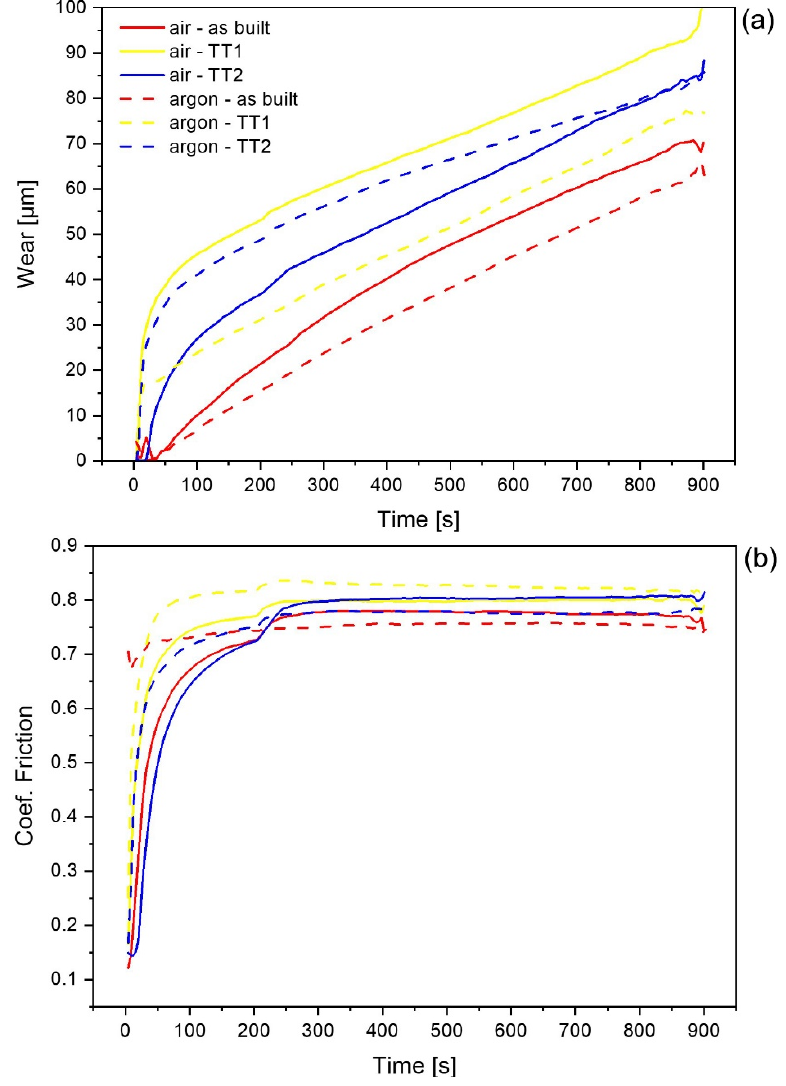
Figure 8. Tribological results: ( a ) wear vs. time; ( b ) coefficient of friction vs. time.